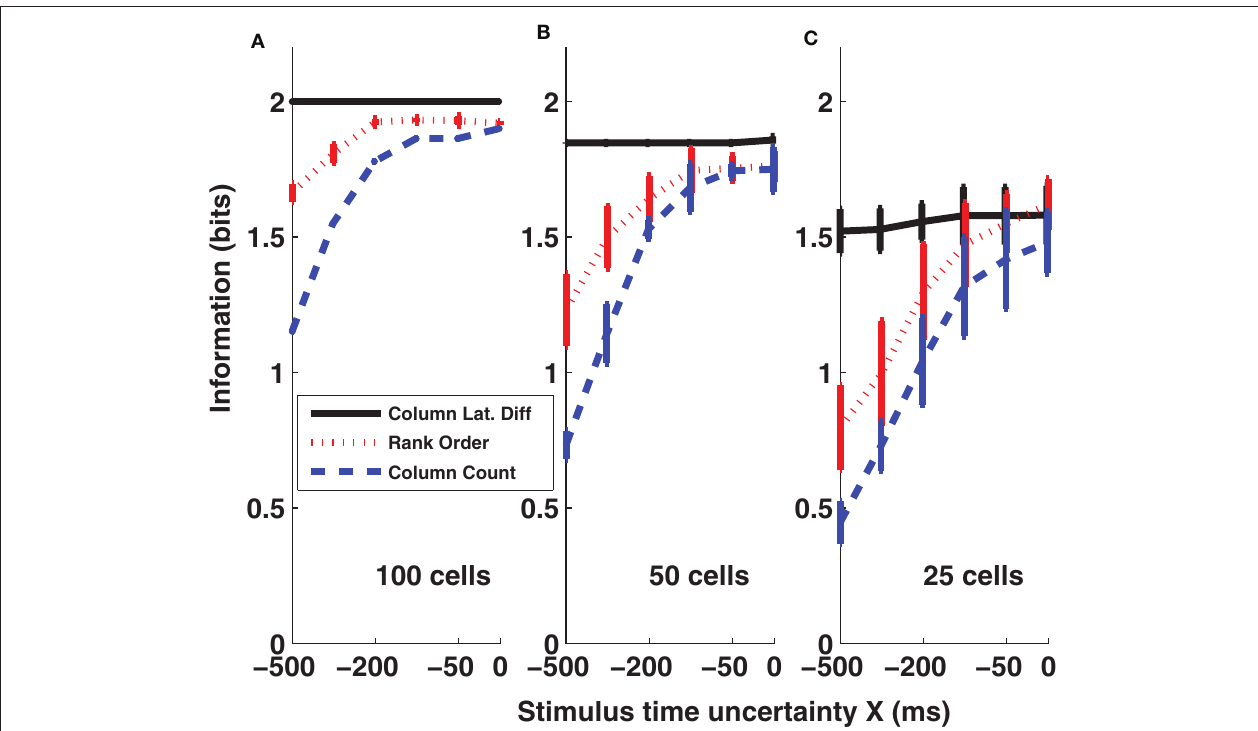
Figure 6 | information obtained by decoding the activity of three columns (barrels D1, D2, and D3). The amounts of information (Eq. 3) decoded by the columnar latency (black line), the rank order (red line) and the columnar count (blue line) decoders respectively are plotted as a function of the parameter